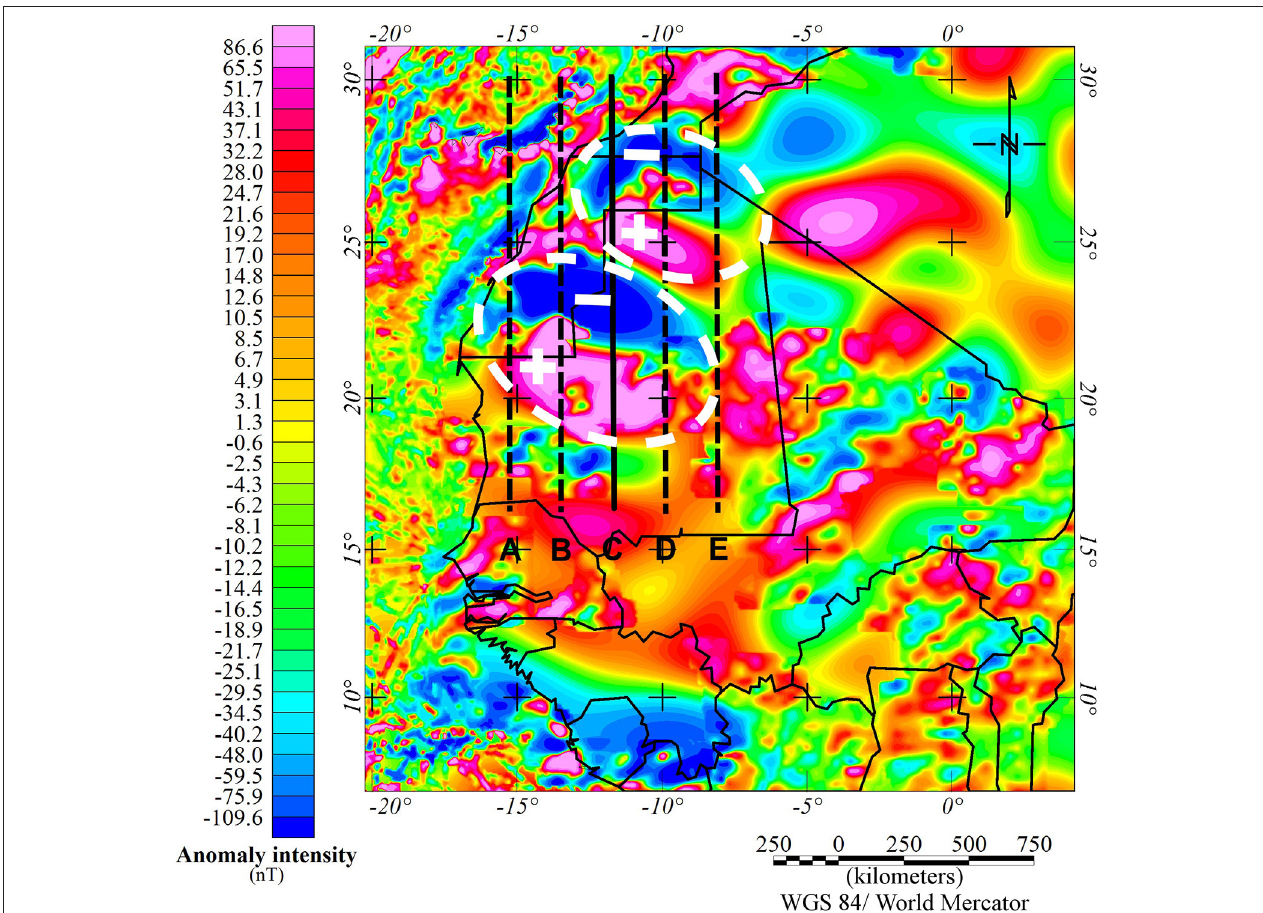
FIGURE 1 | The West Africa Magnetic Anomaly (WAMA) in the World Digital Magnetic Anomaly Map (WDMAM) model at 5km altitude. Segments A–E correspond to the selected profiles used for 2D modeling. Solid segment C corresponds to the profile shown in this